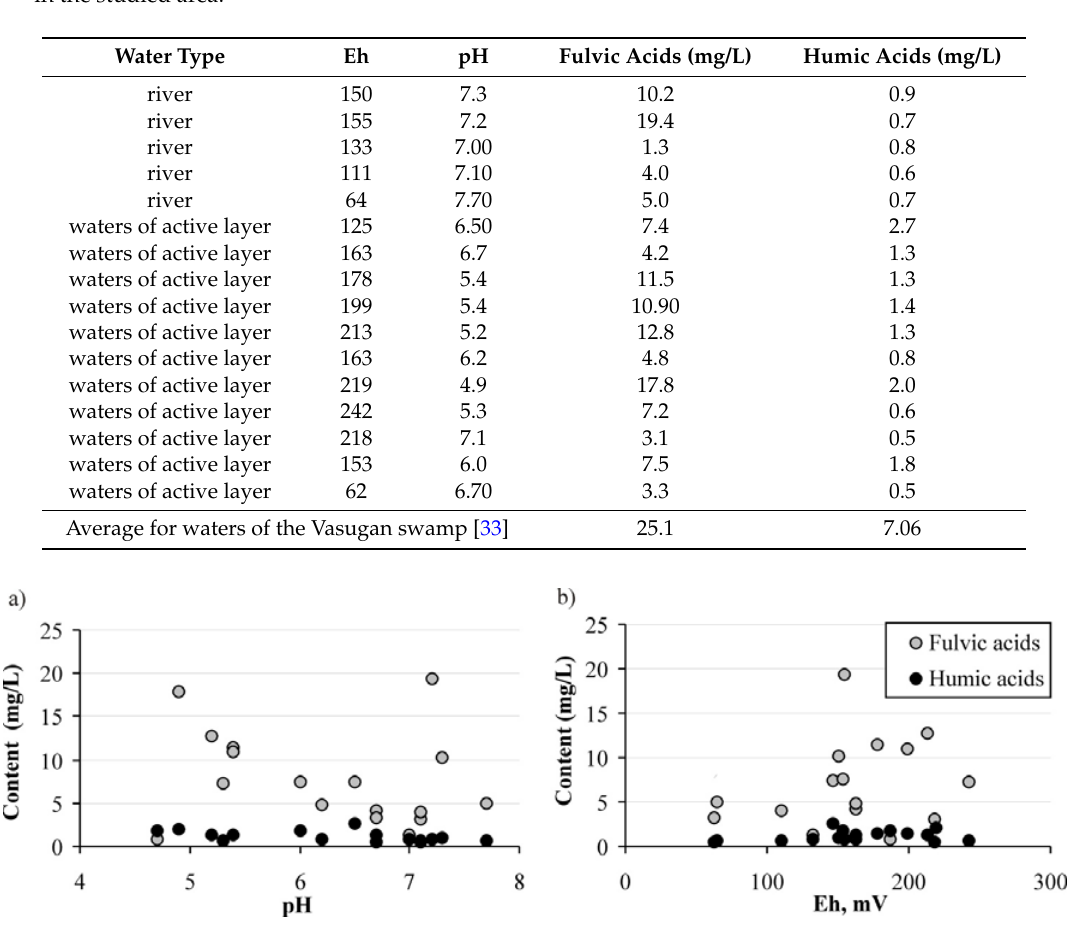
Table 1. The physico-chemical parameters and fulvic and humic acid contents in several water points in the studied area.